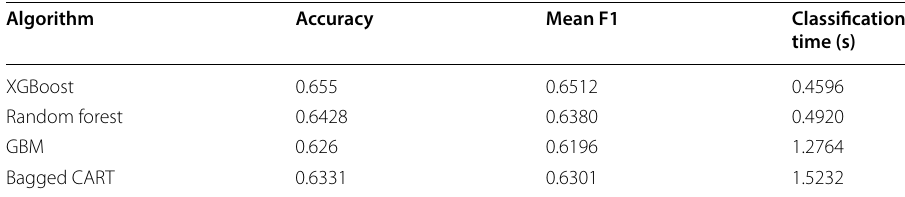
Table 6 Results for age prediction